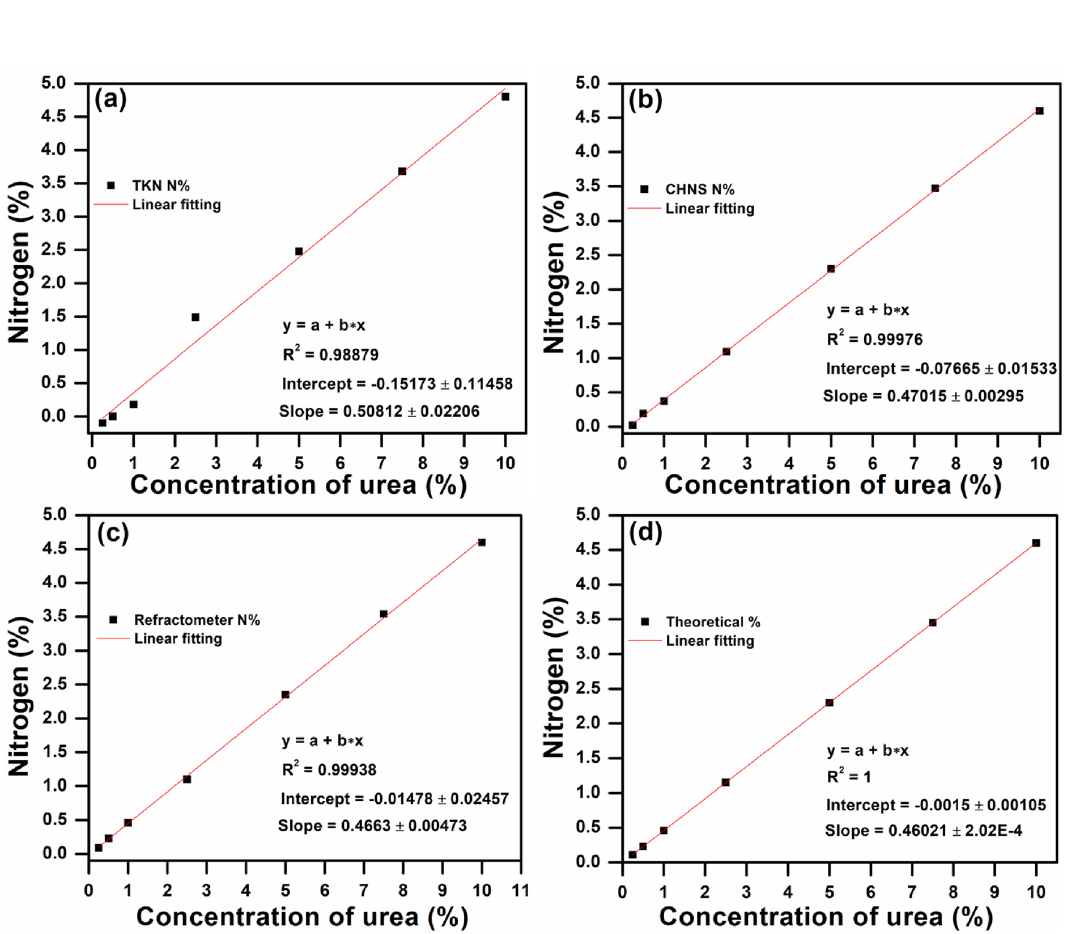
Figure 1. Linear fitting between nitrogen (%) and different concentration of urea from 0.25 to 10% for ( a ) TKN, ( b ) CHNS ( c ) refractometer, and ( d ) theoretical N%. (Both CHNS and refractometer have shown the R 2 value is close to the theoretical value for urea